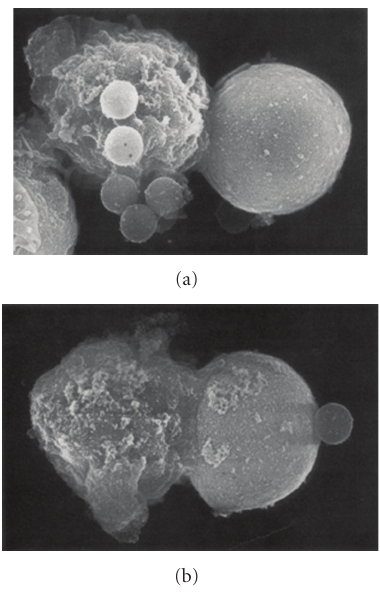
Figure 2: Scanning electron micrographs of conjugates formed between T cells (left) and C. neoformans (right). Magnification in both panels is × 16,370 . Cells in (a) were labelled with mouse monoclonal anti-CD3 antibody followed by goat antimouse IgG bound to latex beads. Latex beads are seen attached to the e ff ector cell (a). Cells in (b) were labelled with UPC10 as a control IgG followed by goat antimouse IgG conjugated to latex beads. One latex bead is seen associated with the cryptococcal cell; however, no beads attached to the e ff ector cell